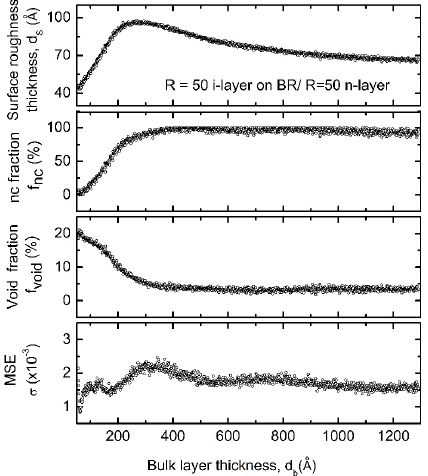
Figure 4. Mean square error (MSE), void fraction ( f void ), nanocrystalline volume fraction ( f nc ), and surface roughness thickness ( d s ) in the top ~10 Å of the bulk layer, plotted versus the accumulated bulk layer thickness for an intrinsic hydrogen diluted R = [H 2 ]/[SiH 4 ] = 50 Si:H film deposited on a 200 Å R = 50 n ‐ type a ‐ Si:H over ‐ deposited onto a ZnO/Ag back reflector (BR), as determined by virtual interface analysis (VIA) applied to real time spectroscopic ellipsometry (RTSE) data. Spectrally averaged mean error for f void , f nc , and d s are 0.3%, 2.4%, and 0.8 Å respectively.